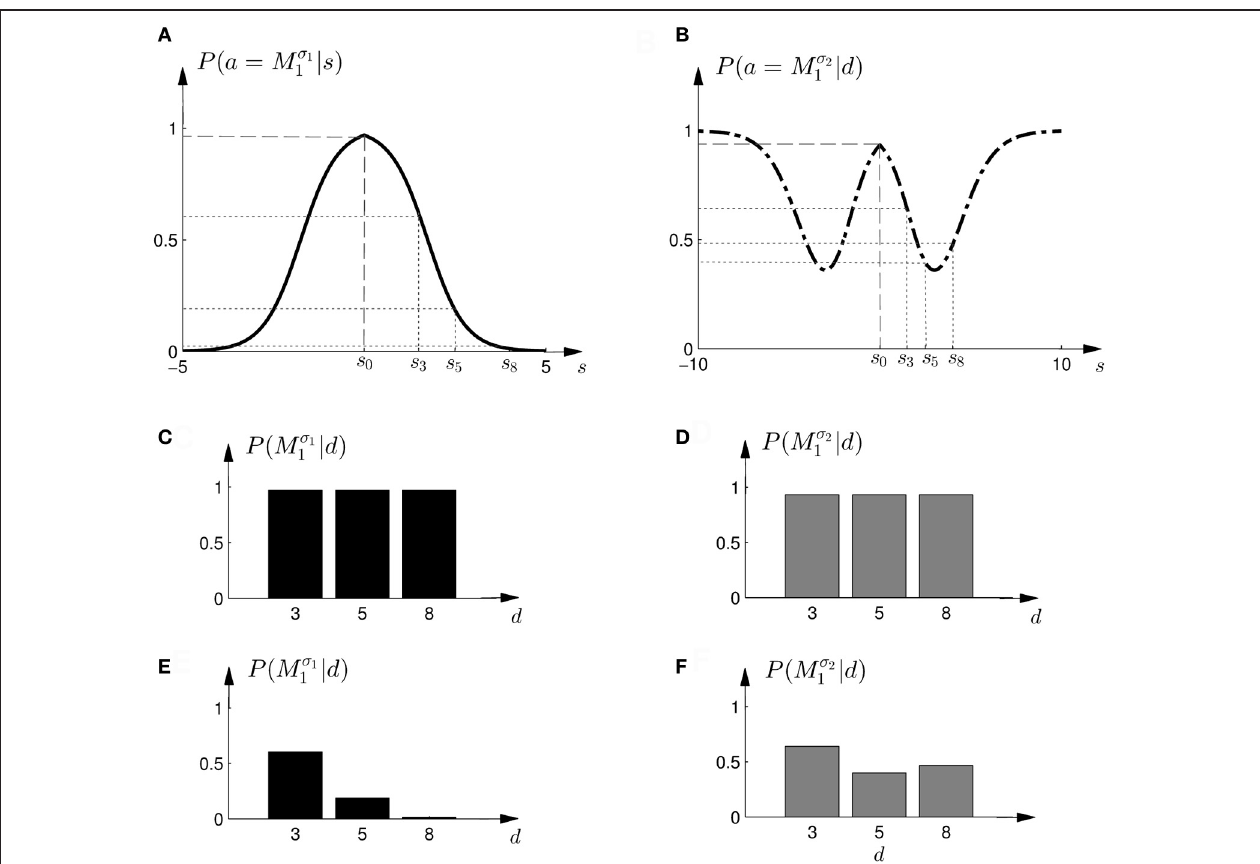
FIGURE 11 | Construction of predicted choice probabilities following heuristics. (A,B) Show the fitted choice probabilities of selecting model M 1 in standard trials of the same subject shown in Figure 8 . For the “average shift”-heuristic the shift s 0 is always assumed in the probe trials. For the “biggest shift”-heuristic the shift is always assumed to be the largest possible shift that depends on the width of the feedback